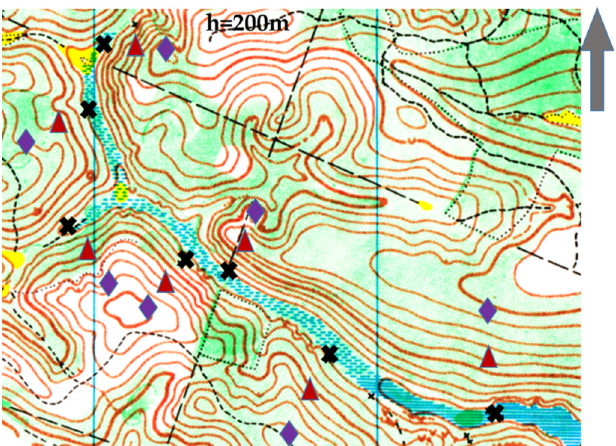
Figure 2. The studied branched ravine. The sampling sites and corresponding habitats are indicated as follows: the bottom of ravine or the banks of a temporary stream are marked with black crosses, the slope of the ravine is marked with red triangles, and the forest on the plakor is marked with purple diamonds. Scale 1:15,000. The arrow points to the north.